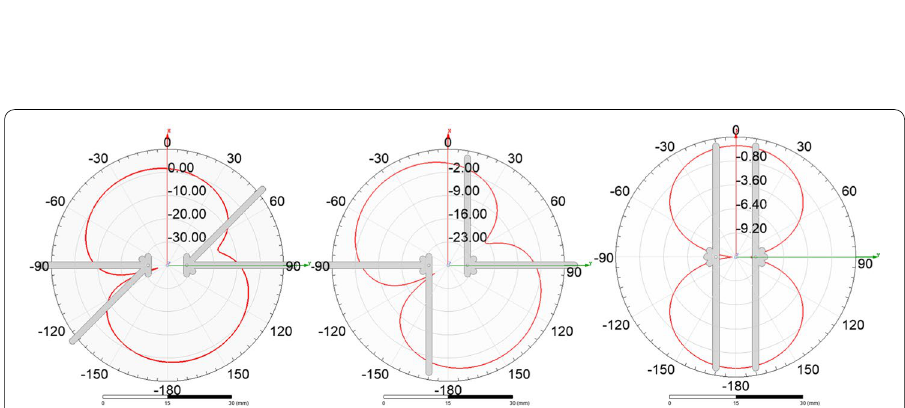
Fig. 12 Simulated radiation pattern 2. Simulated radiation patterns for a liquid metal dipole antenna with superpositions of dipole